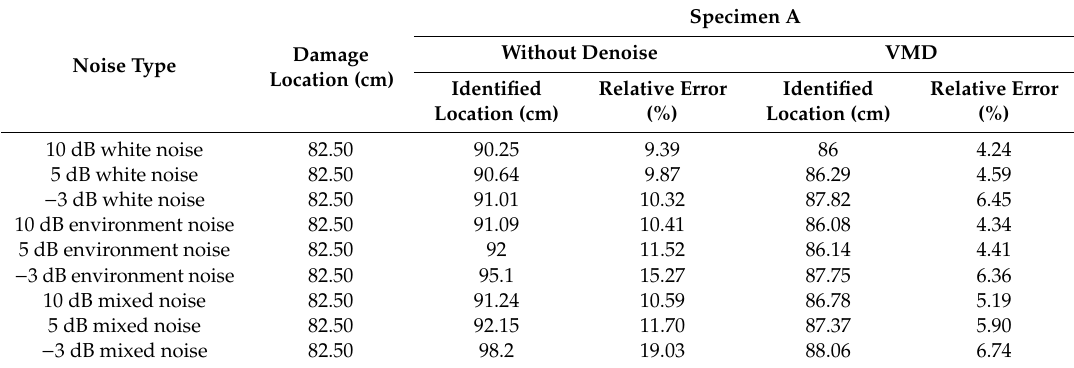
Table 2. Statistics of damage location results of specimen A before and after noise reduction using VMD in different noise environments.